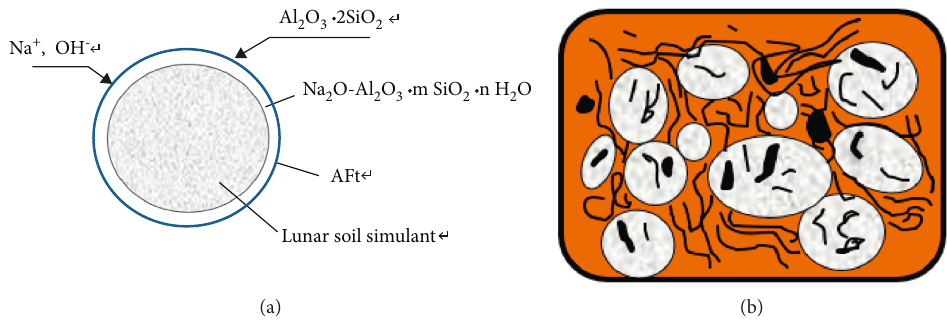
Figure 15: The curing mechanism diagram. (a) Alkali excitation. (b) Adsorption